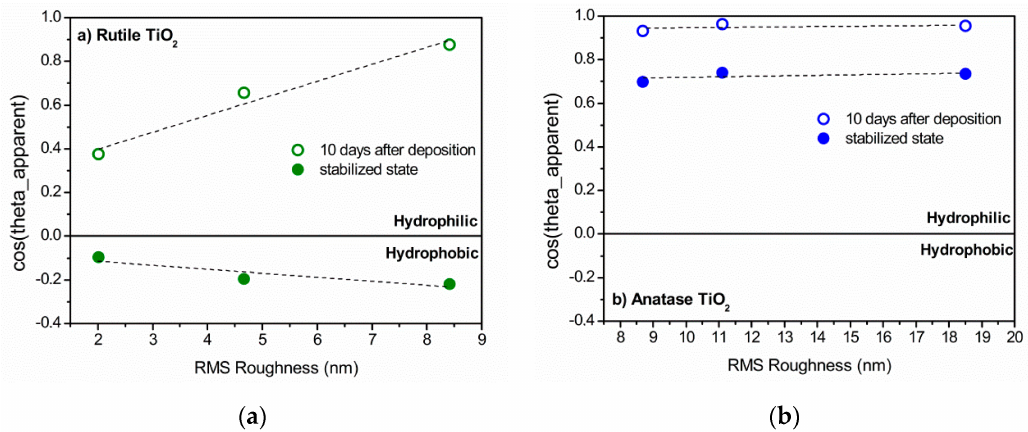
Figure 7. The cosine of the apparent contact angle of glancing angle deposited TiO 2 films ( a ) rich in rutile (65–100%) and ( b ) rich in anatase (45–100%), as a function of the RMS roughness of the